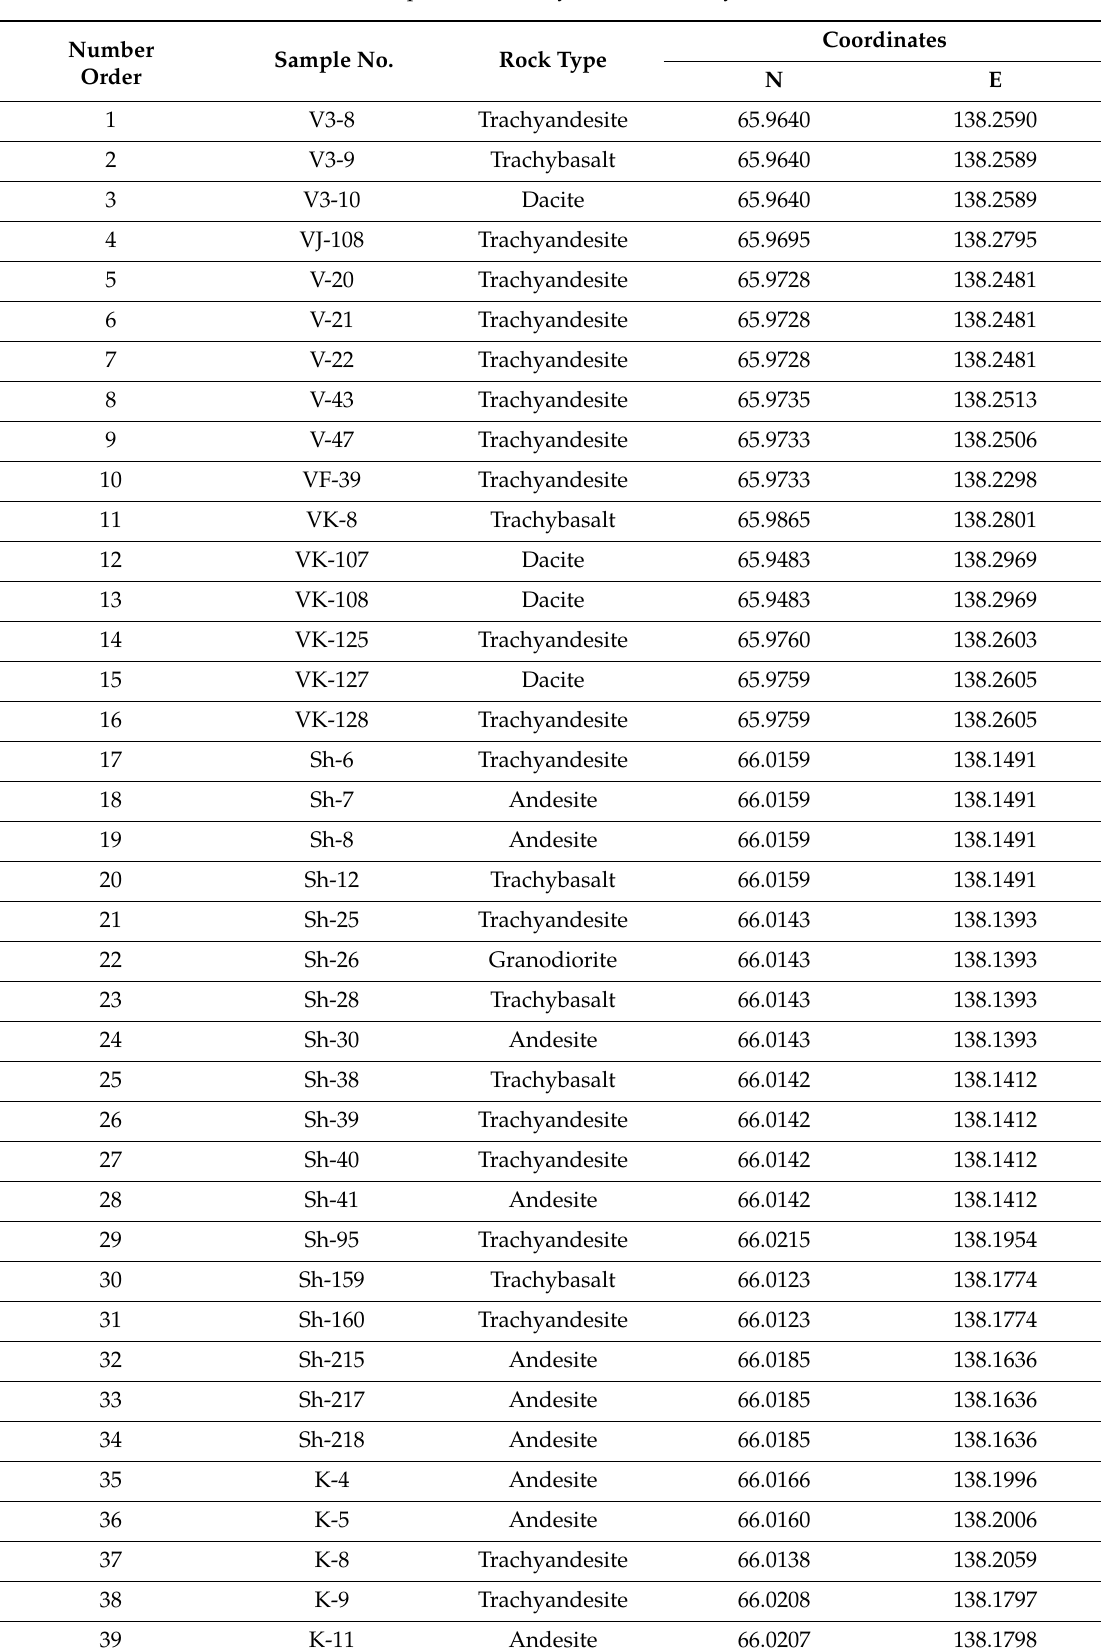
Table 1. List of the studied samples from the Vyun and Shumniy sites with GPS